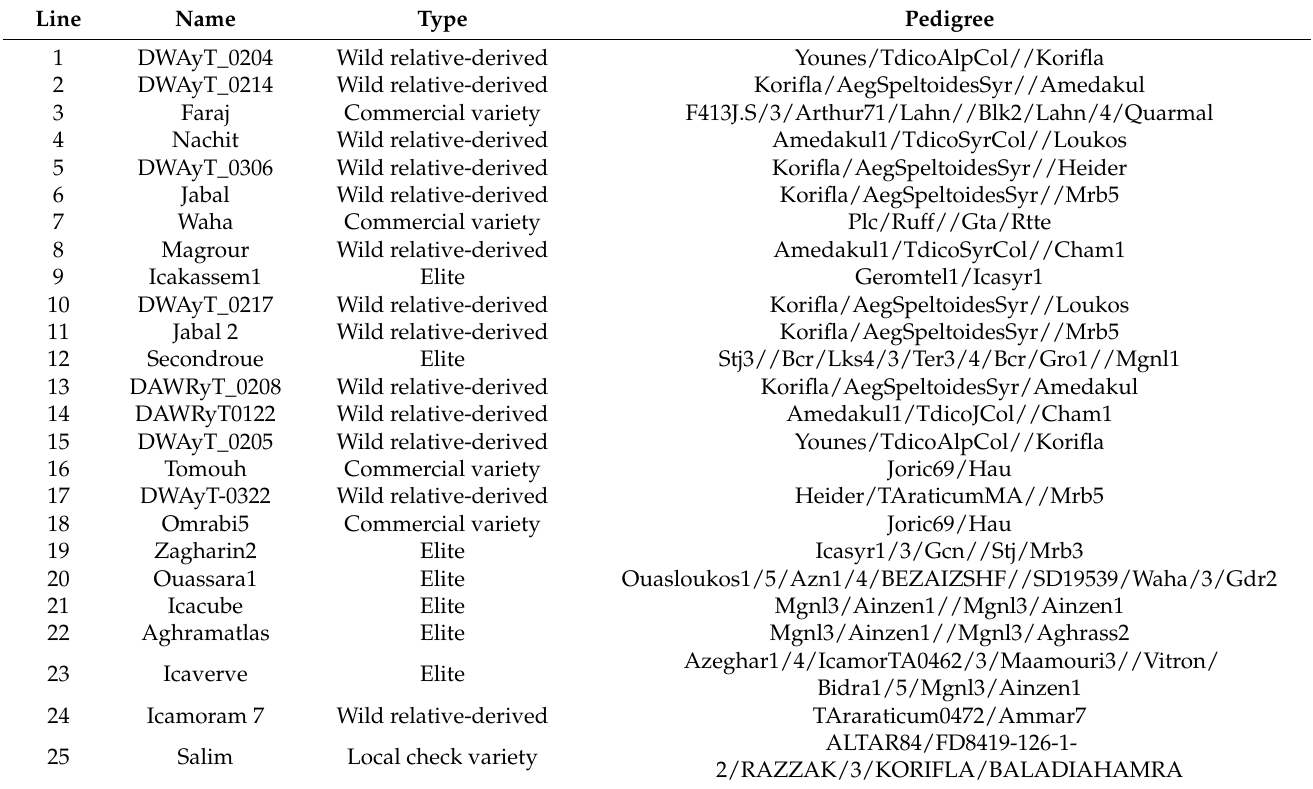
Table 1. List and pedigree of durum wheat genotypes used in the study.